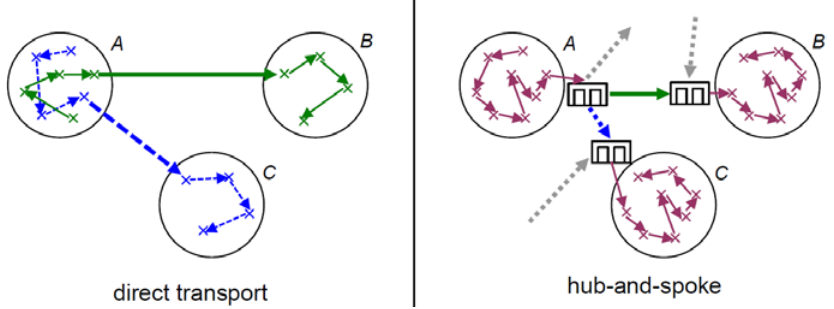
Figure 1. Organisation of road transport operations: direct transport vs hub-and-spokes